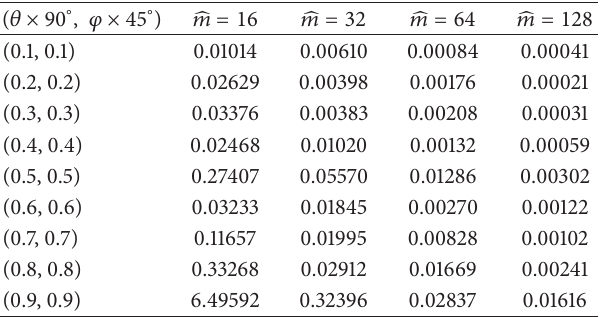
Table 2: The absolute errors between original RCS and reproduced RCS for different ̂𝑚 (dB).